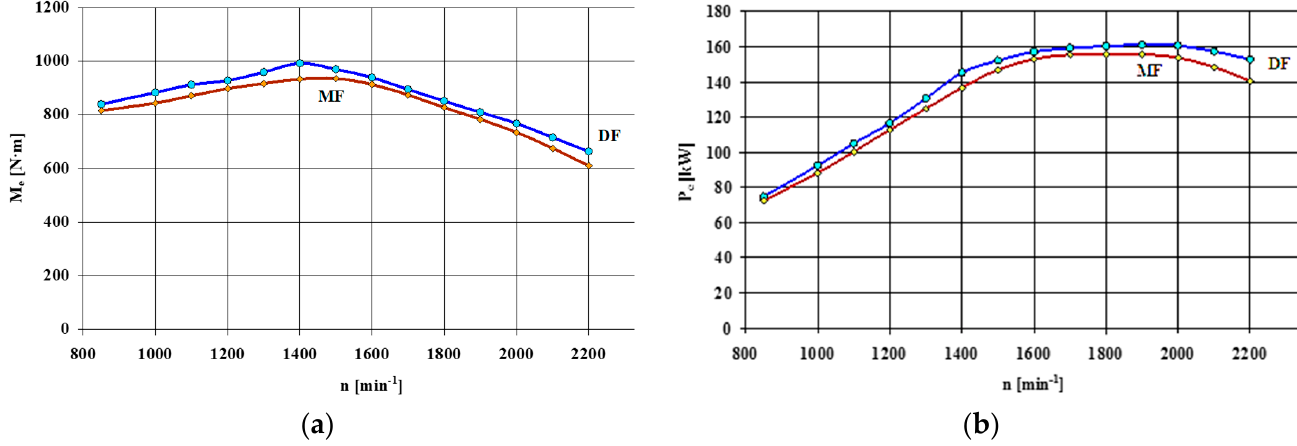
Figure 5. External speed characteristics of Cummins 6C 8.3 engine: ( a ) torque and ( b ) effective power, for a self-ignition, diesel-fueled engine (DF), and a spark-ignition, methane fuel—natural gas—supplied engine (MF).